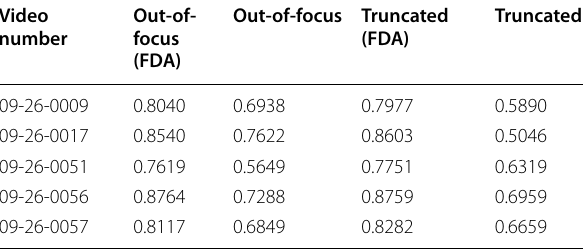
Table 5 Performance comparison of multi-sensor fault tolerance Video number